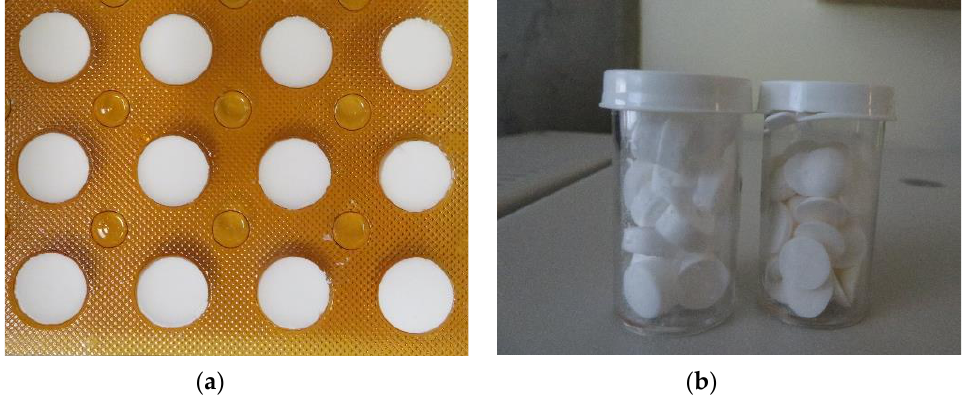
Figure 2. Sublingual oxytocin optimized formulation: ( a ) freeze-dried oxytocin tablets in blister sheet; ( b ) representative freeze-dried tablets in bottles.